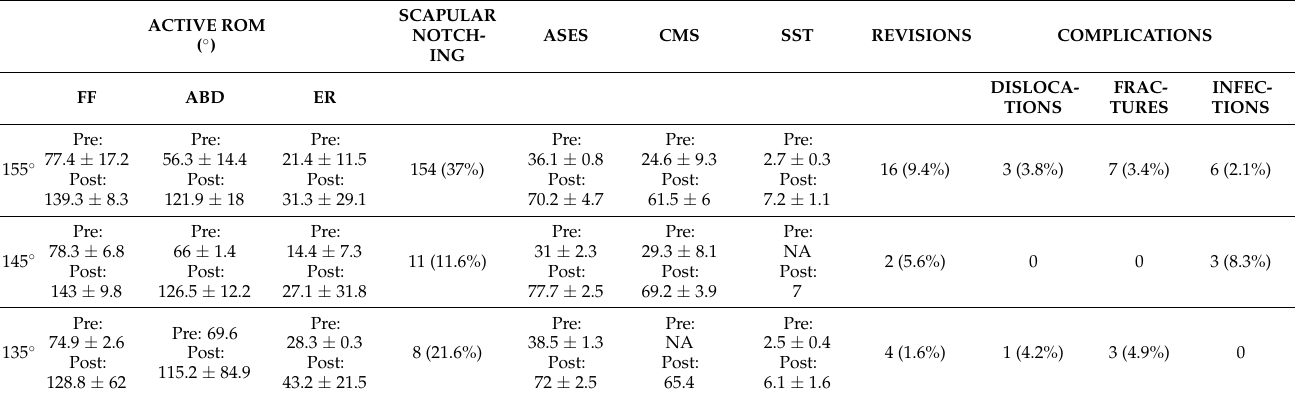
Table 7. Comparison between different implant